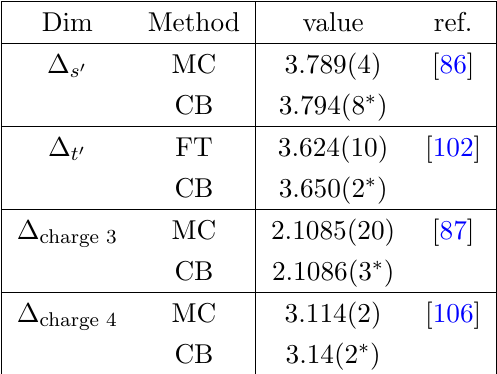
(cid:30) j (cid:30) and (cid:30) (cid:30) j (cid:30) k (cid:30) . ( i k ) ( i l ) to 10 (cid:0) 4 (cid:28)